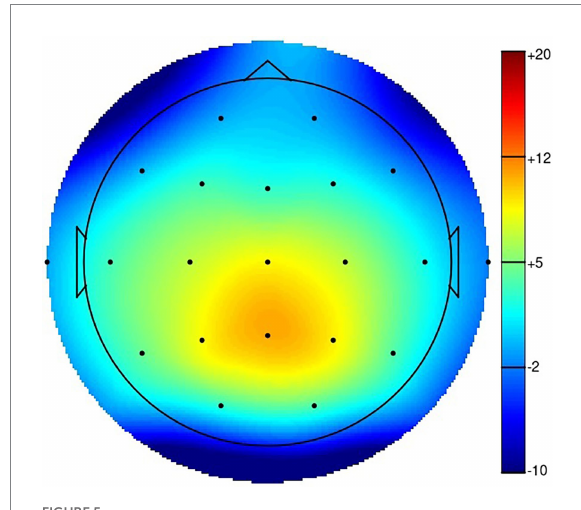
FIGURE 5 Topographical map of the P300. Infrequent - frequent, 400 ms.